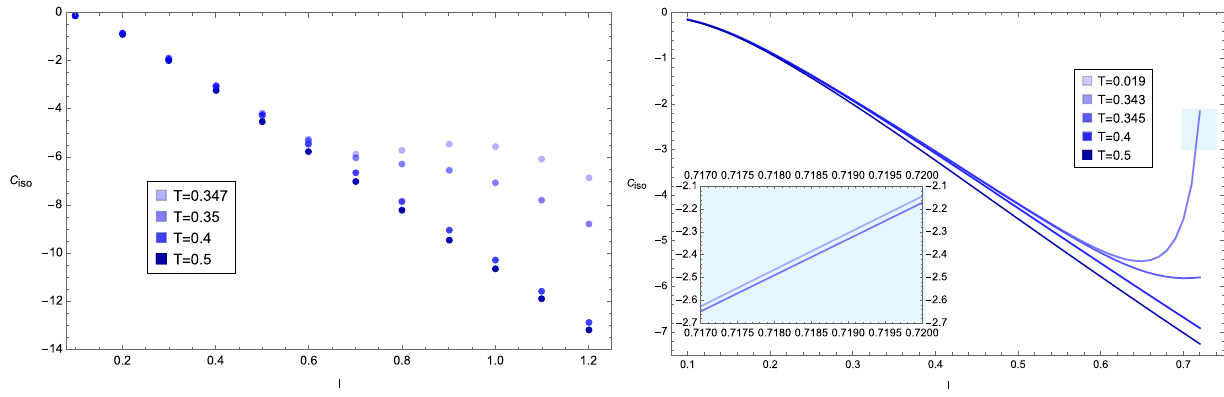
Fig. 5 Left: C iso in terms of l for μ = 0 and four values of temperatures near to T HP ≈ 0 . 346. Right: C iso as a function of l for μ = 0 . 05 and different values of the temperature below and above the phase transition temperature, T BB ≈ 0 .